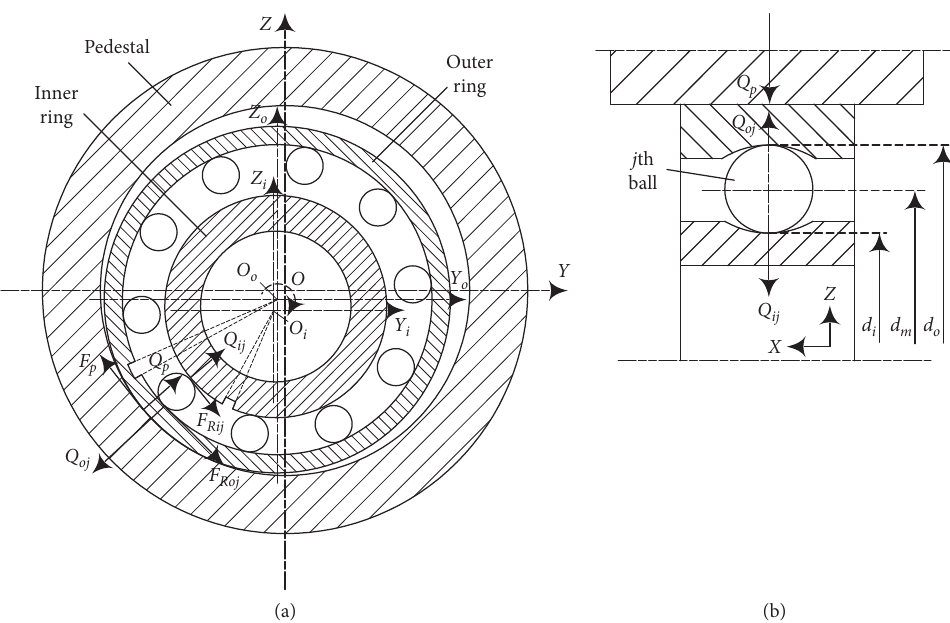
Figure 2: Contact model with clearance in various planes. (a) YOZ plane. (b) XOZ